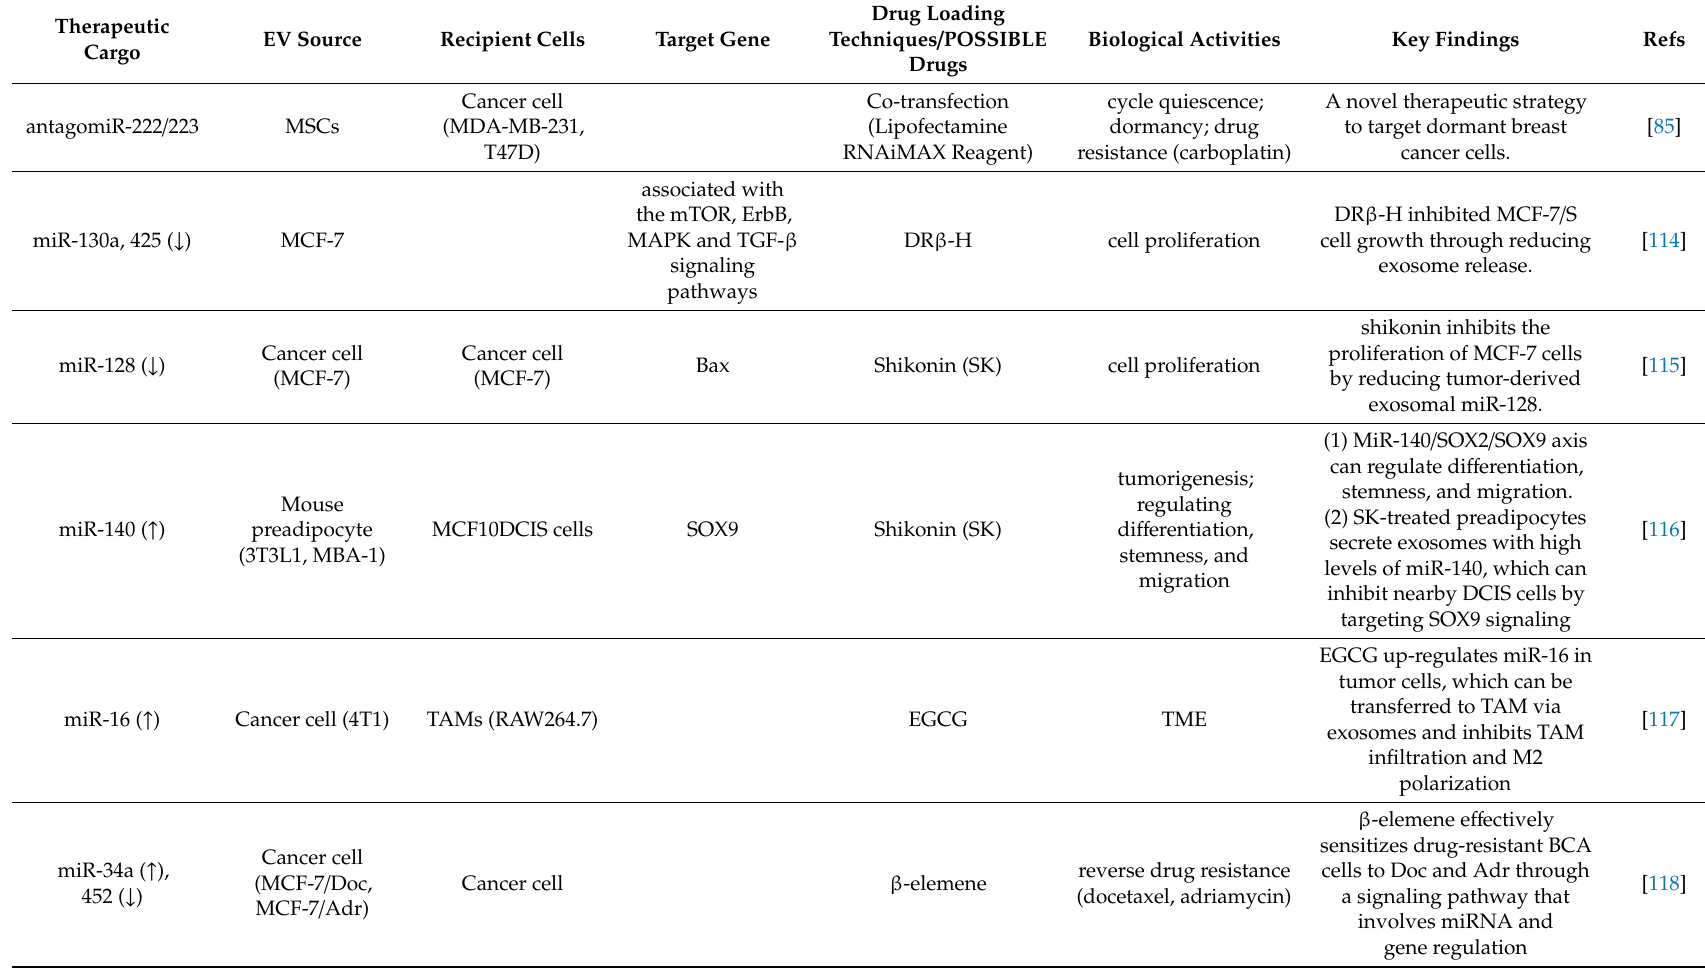
Table 5. EVs as drug delivery agents for cancer